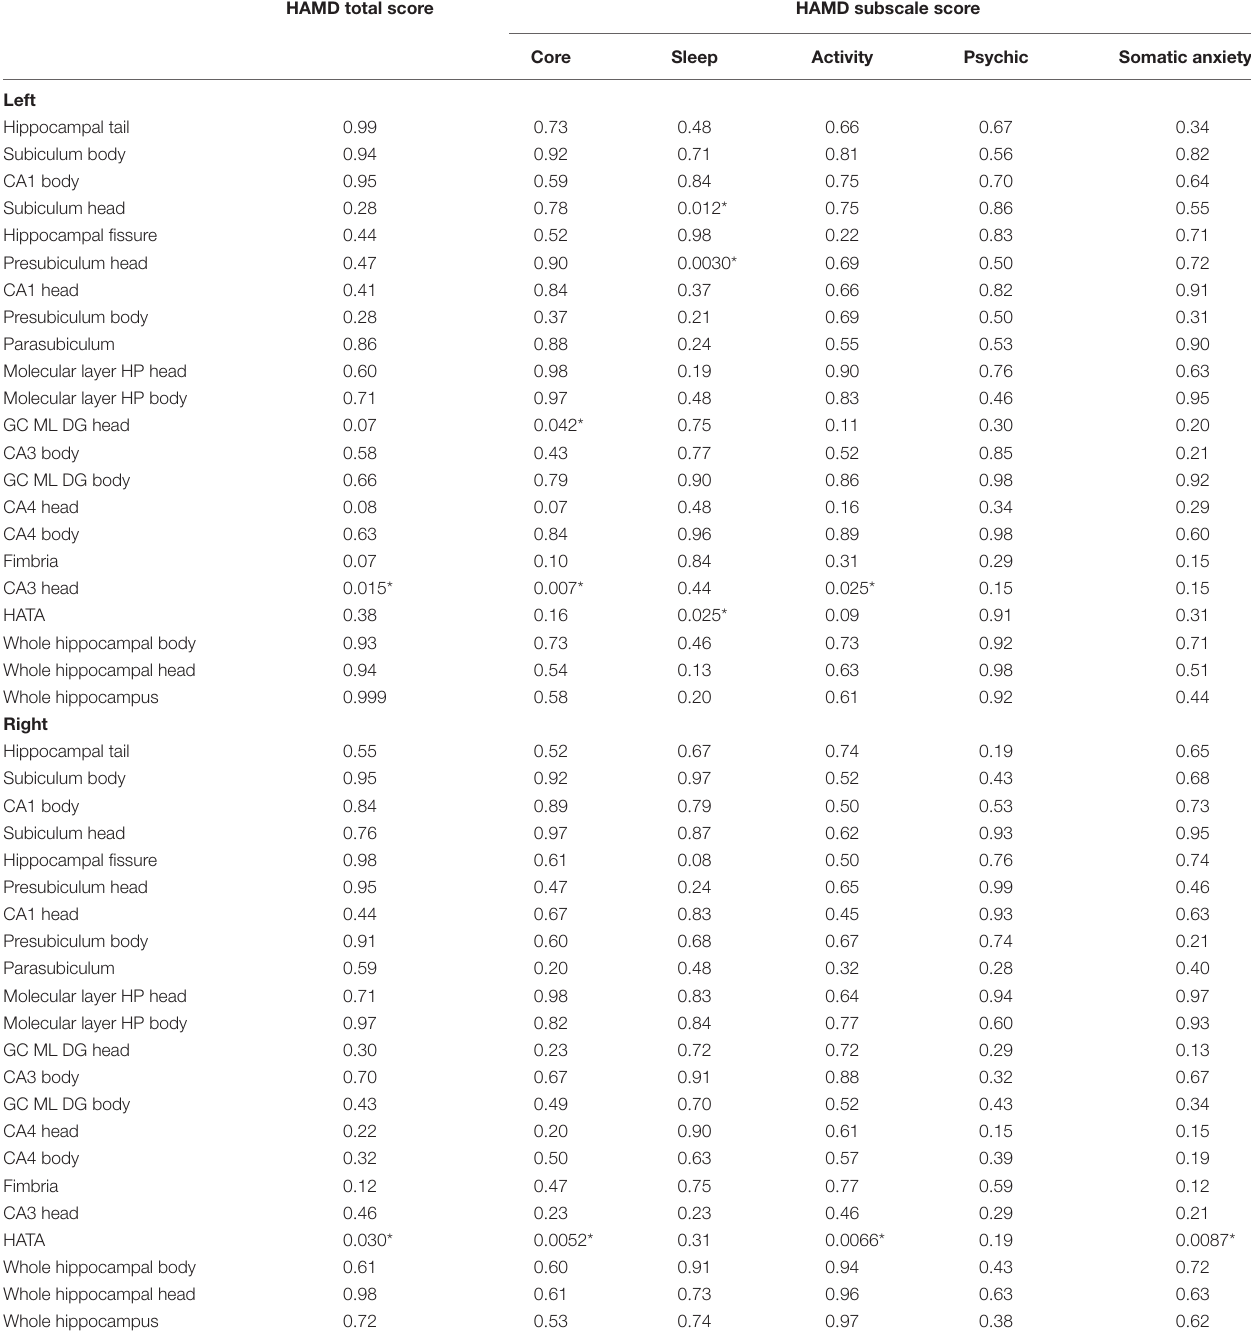
TABLE 5A | The HAMD scores and hippocampus